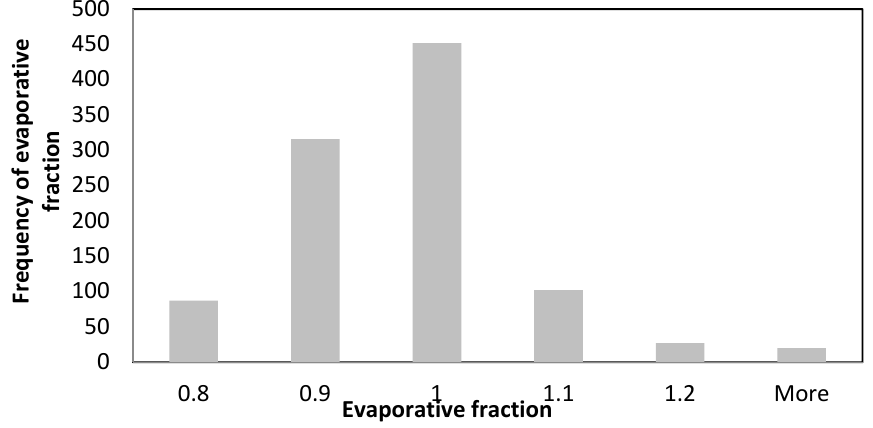
Figure 2. Stability of the evaporative fraction during a day over the Mediterranean Sea (January 2010–September 2012).